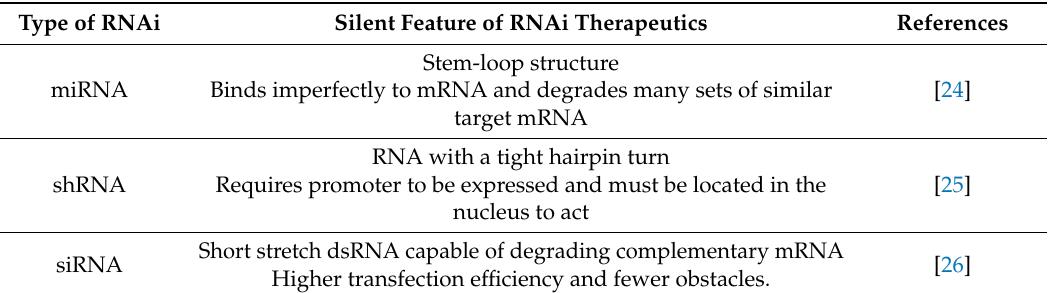
Table 1. Types of RNAi